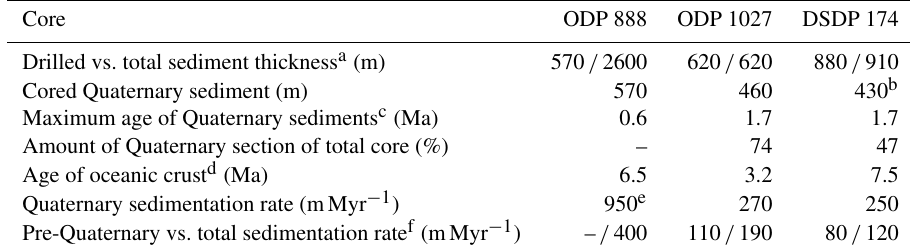
Table 1. Data for the ocean drill cores shown in Fig. 3. Core ODP 888 ODP 1027 DSDP 174 Drilled vs. total sediment thickness a (m) 570 / 2600 620 / 620 880 / 910 Cored Quaternary sediment (m) 570 460 430 b Maximum age of Quaternary sediments c (Ma) Amount of Quaternary section of total core (%) Age of oceanic crust d (Ma) Quaternary sedimentation rate (mMyr − 1 ) 950 e 270 250 Pre-Quaternary vs. total sedimentation rate f (mMyr − 1 ) – / 400 110 / 190 80 /